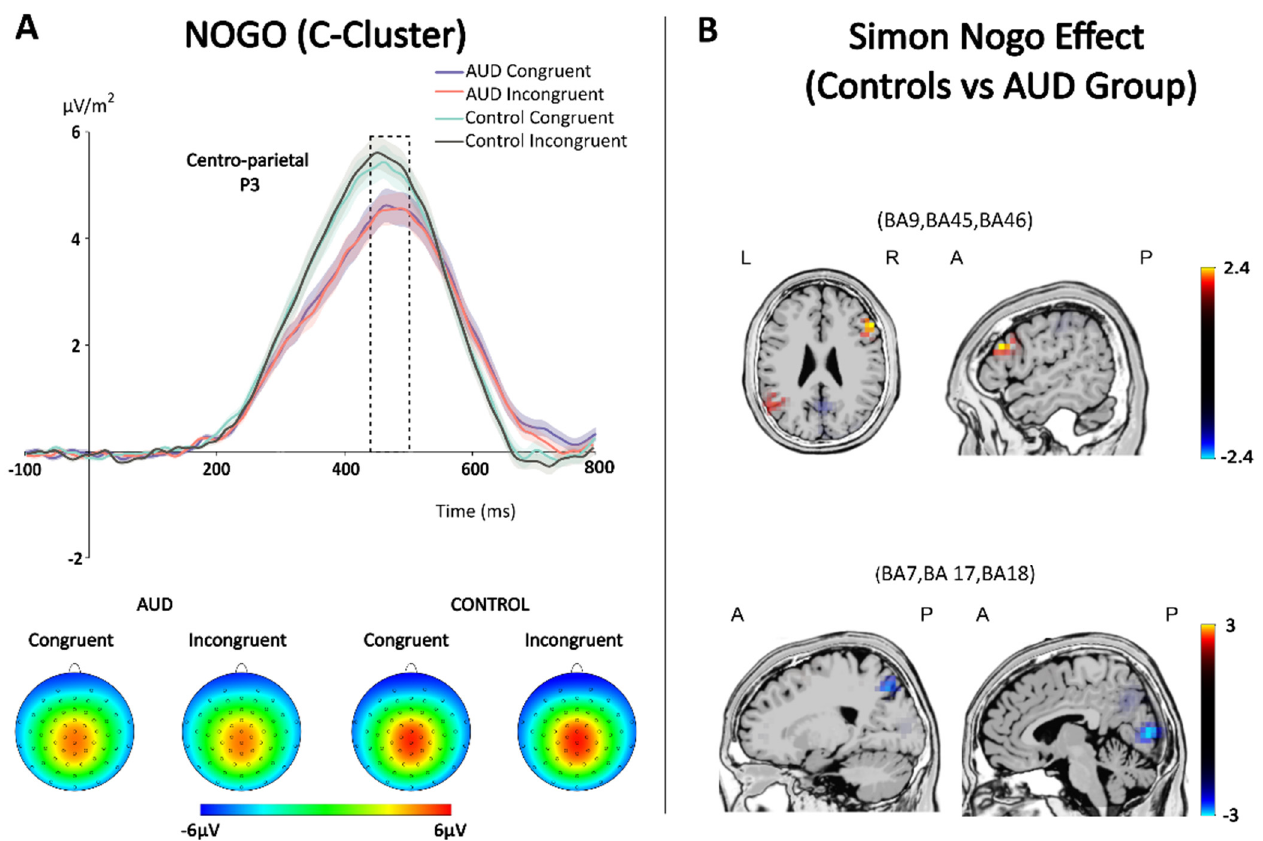
Figure 4. ( A ) The centro-parietal P3 ERP (pooled across Cz and CPz) and corresponding scalp topography maps for Nogo trials in the C-cluster. The different colors of the ERP lines indicate the different experimental groups and conditions. The shaded areas represent the 95% confidence interval estimates. The dashed box illustrates the time window used for the statistical analyses. ( B ) sLORETA-derived maps for the Simon Nogo effect indicate the sources of maximal differences between the control group and AUD group in the dashed time window. Positive values indicate larger activation differences in the control group, and negative values indicate larger activation differences in the AUD group.